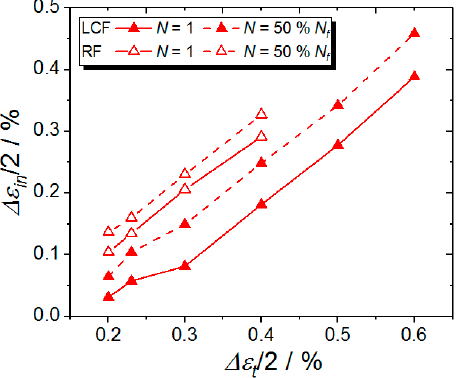
Figure 20. Inelastic strain amplitude at N =1 and at N = 50% N f of the LCF- and RF-tests at 620